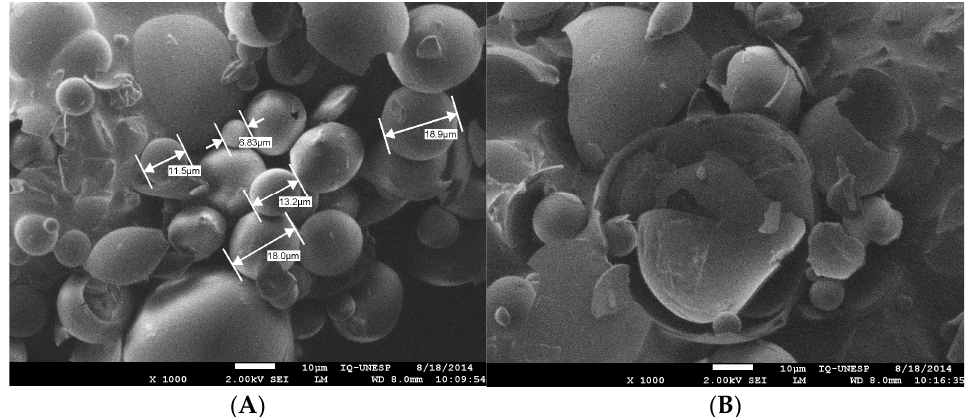
Figure 2. Microscopic aspects of the two propolis extract powders obtained by spray-dryer technology: ( A ) microencapsulated propolis extract (MPE) (40:60 propolis–gum Arabic); ( B ) propolis soluble dry extract (PSDE) (80:20, propolis–maltodextrin).